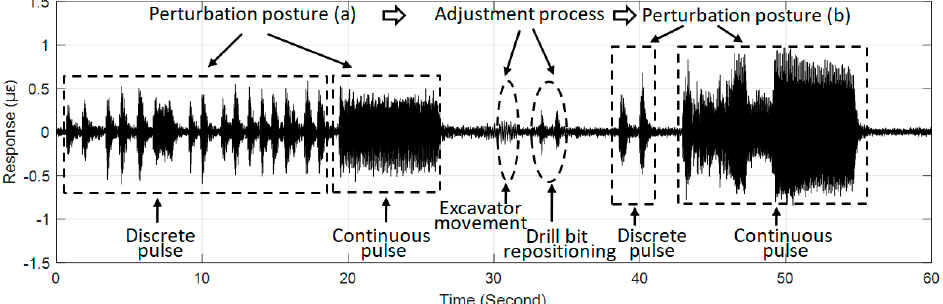
Figure 8. Distributed vibration response of #159 zone of the tunnel wall under the perturbation of position P1.